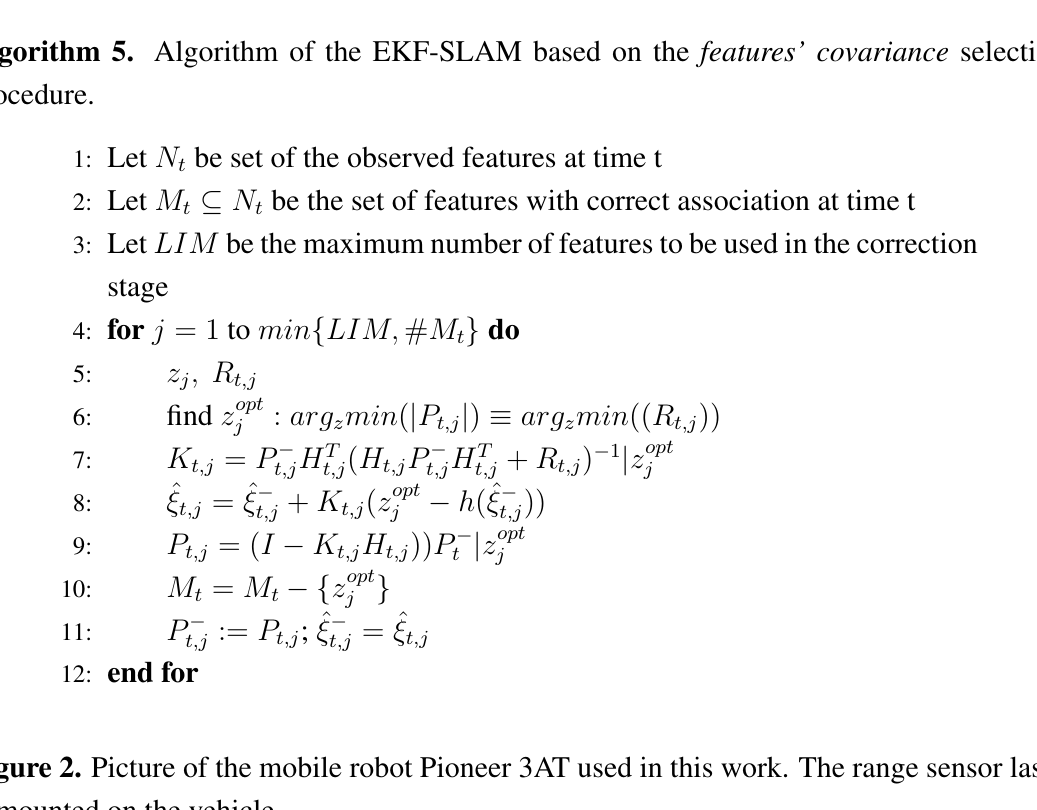
Algorithm 5. Algorithm of the EKF-SLAM based on the features’ covariance selection procedure.